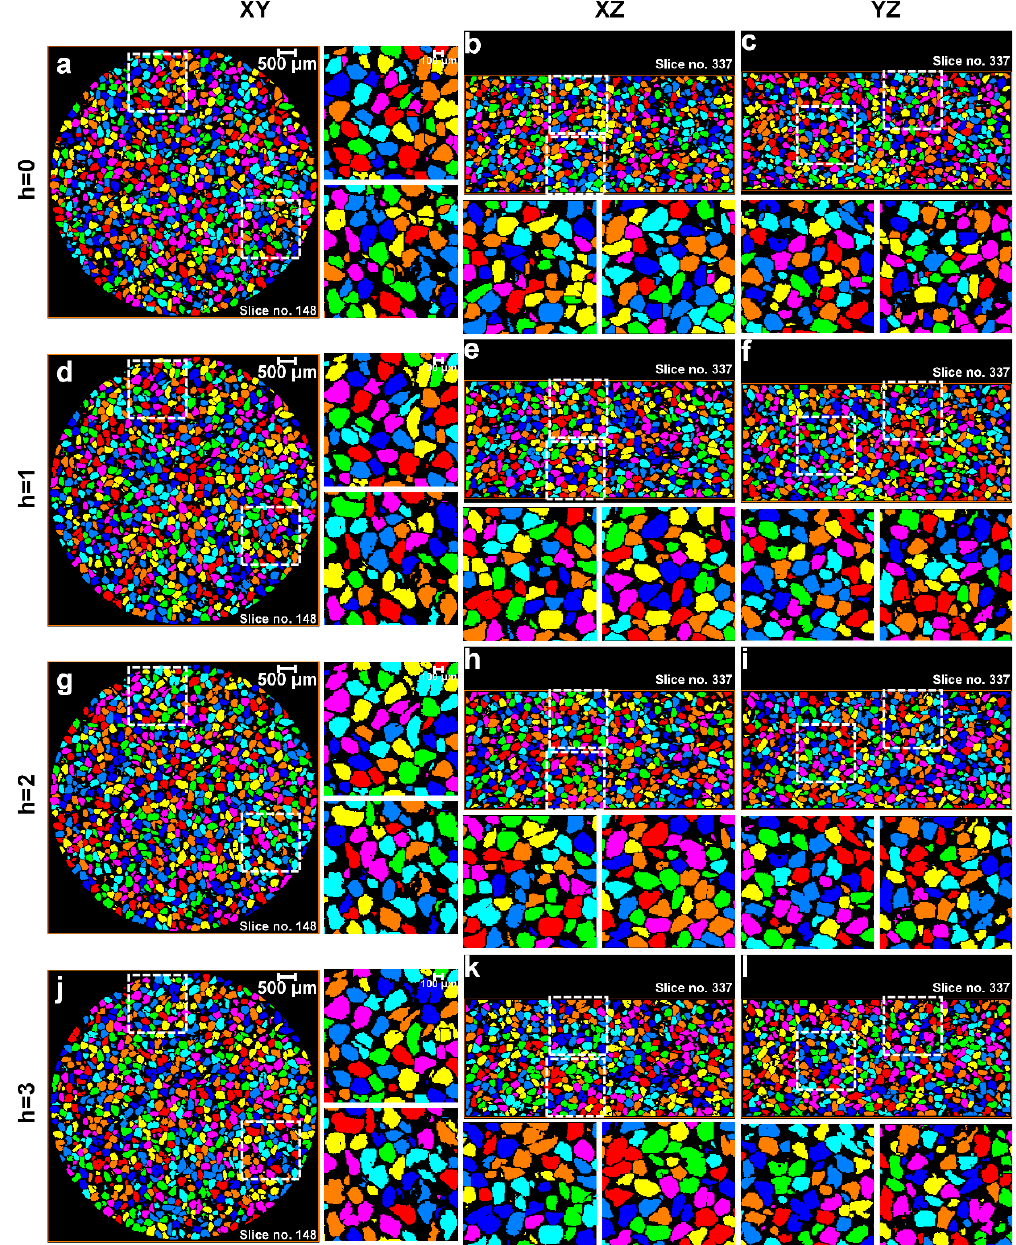
Figure 12. Separation outcomes (XY, XZ, and YZ views through the centre of the sand volumes) for the sand volume compressed under 16 MPa stress and separated using the watershed method with a h -value of: ( a – c ) h = 0; ( d – f ) h = 1; ( g – i ) h = 2; and ( j – l ) h = 3.